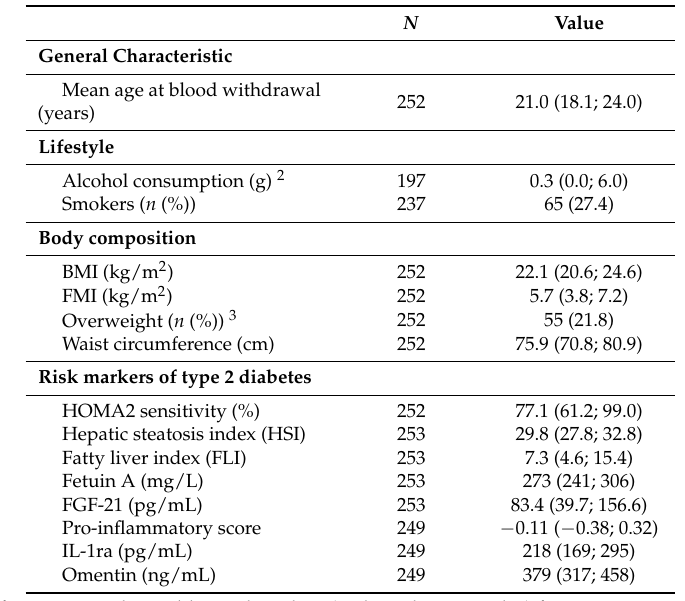
Table 2. Sample characteristics for young adulthood 1